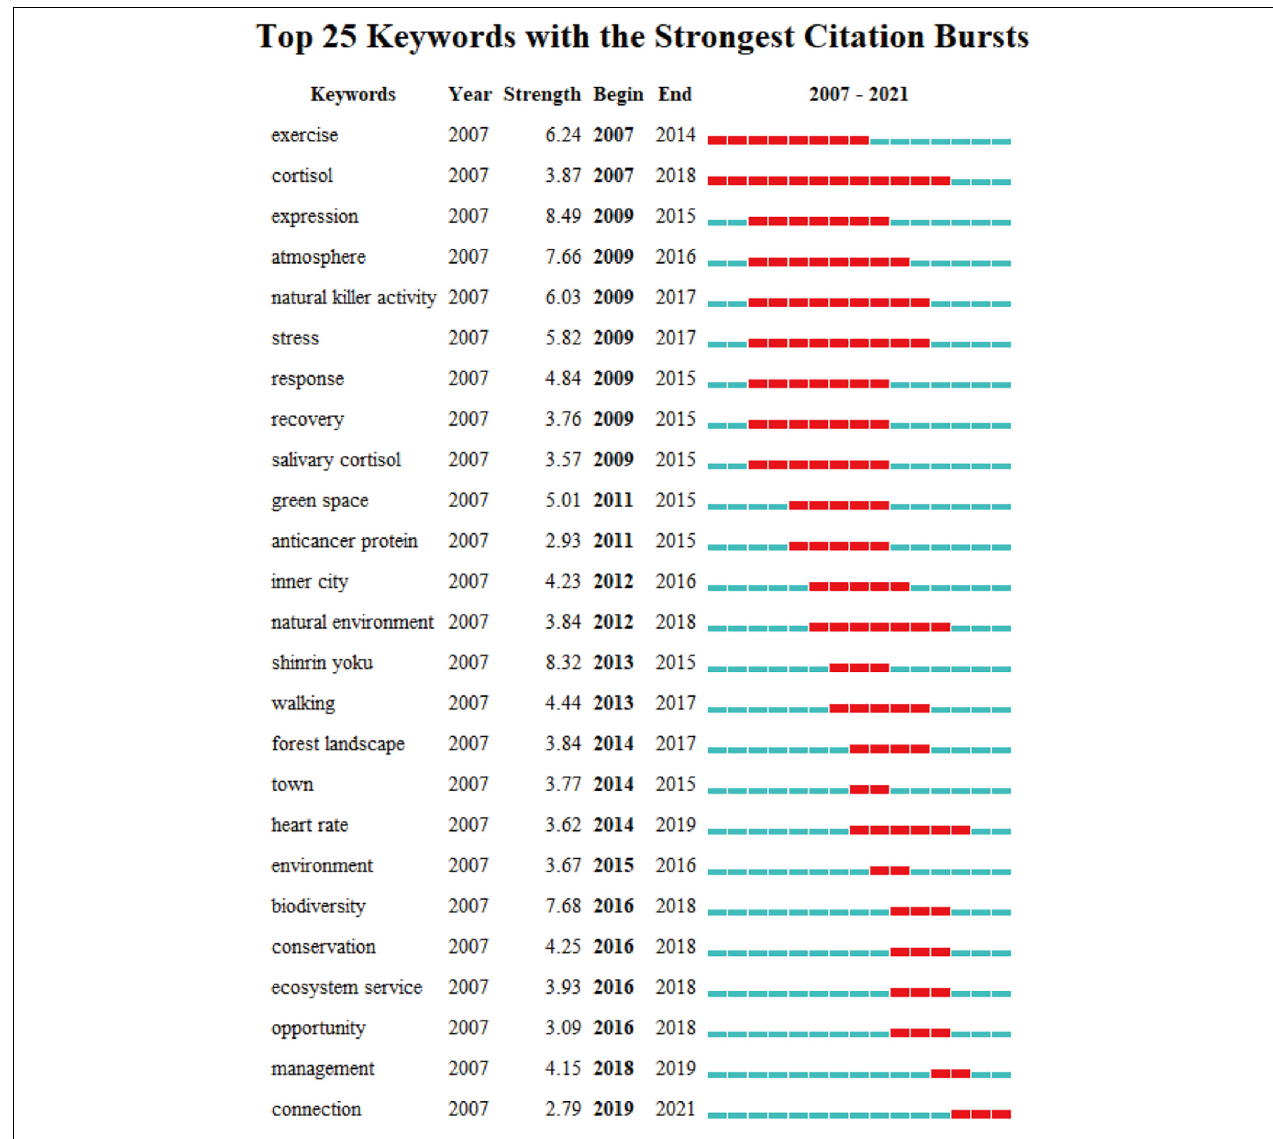
FIGURE 5 | The keywords with the strongest citation bursts in publications on forest therapy research.